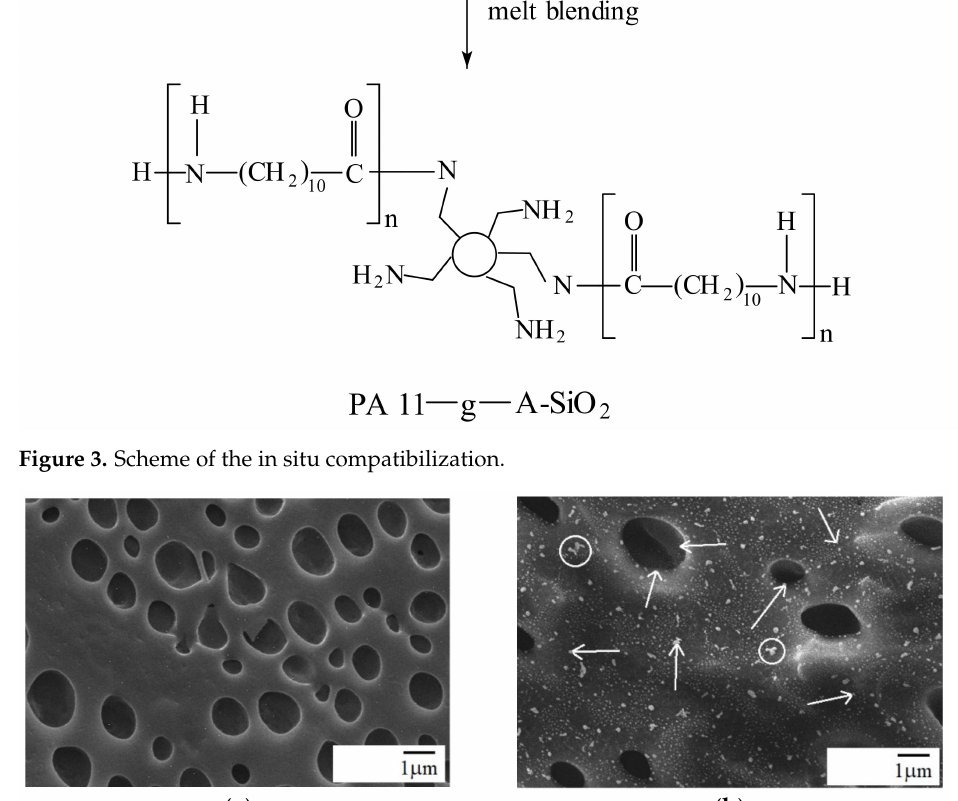
Figure 4. Chloroform etched SEM micrographs: ( a ) PPO/PA11 80/20 blend and ( b ) PPO/PA11/1 wt.% A-SiO 2 composite; arrows—silica particles, circles—silica agglomerates; all images were re- ported at scales of 1 µ m.